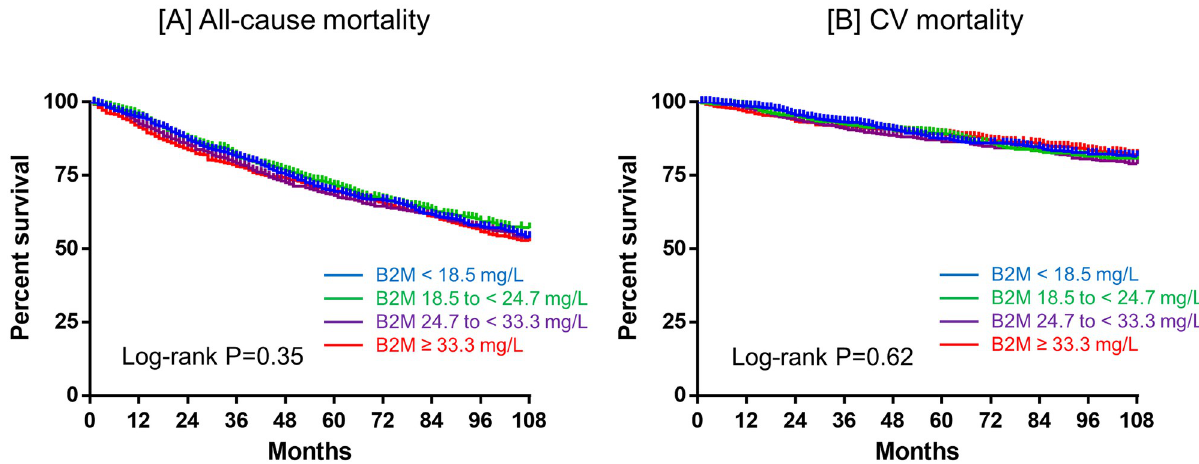
Fig 2. Kaplan-Meier curve of all-cause (A) and CV mortality (B). These parameters were compared between four groups according to serum B2M. Abbreviations: CV, cardiovascular; B2M, β 2 microglobulin. https://doi.org/10.1371/journal.pone.0266882.g002 1.71; 95%CI 1.40 to 2.08, respectively), whereas lower serum B2M ( < 18.5 mg/L) did not affect all-cause mortality (HR 0.98; 95%CI 0.83 to 1.17). Fig 3 shows the results of restricted cubic spline curve. An unadjusted analysis revealed that all-cause mortality is constant regardless of serum B2M, whereas an adjusted analysis revealed a linear correlation between serum B2M Table 3. HR and 95% CI of all-cause mortality and SHR and 95% CI of CV mortality. HR and 95% CI of all-cause mortality SHR and 95% CI of CV mortality Unadjusted Adjusted Unadjusted